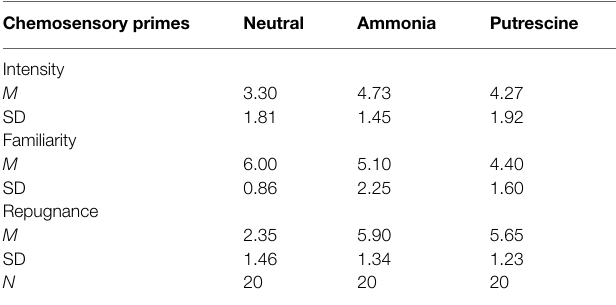
TABLE 2 | Scent ratings for the chemosensory primes (Experiment 1). Chemosensory